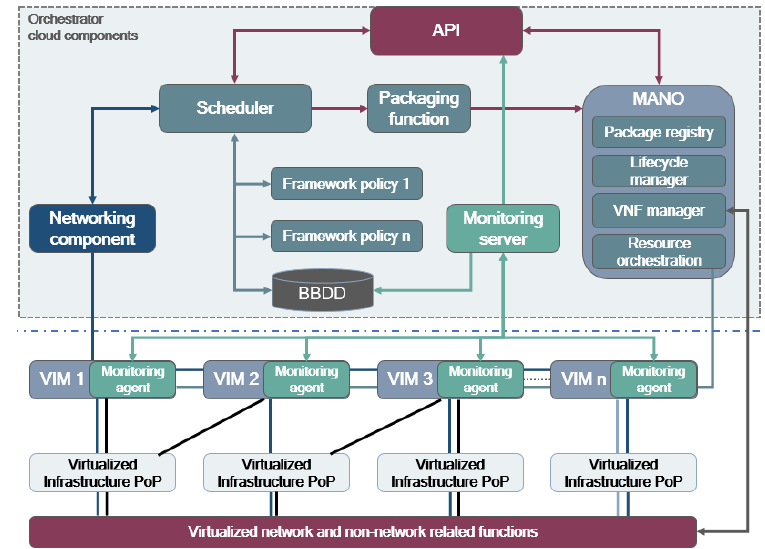
Figure 12. High-level smart orchestrator